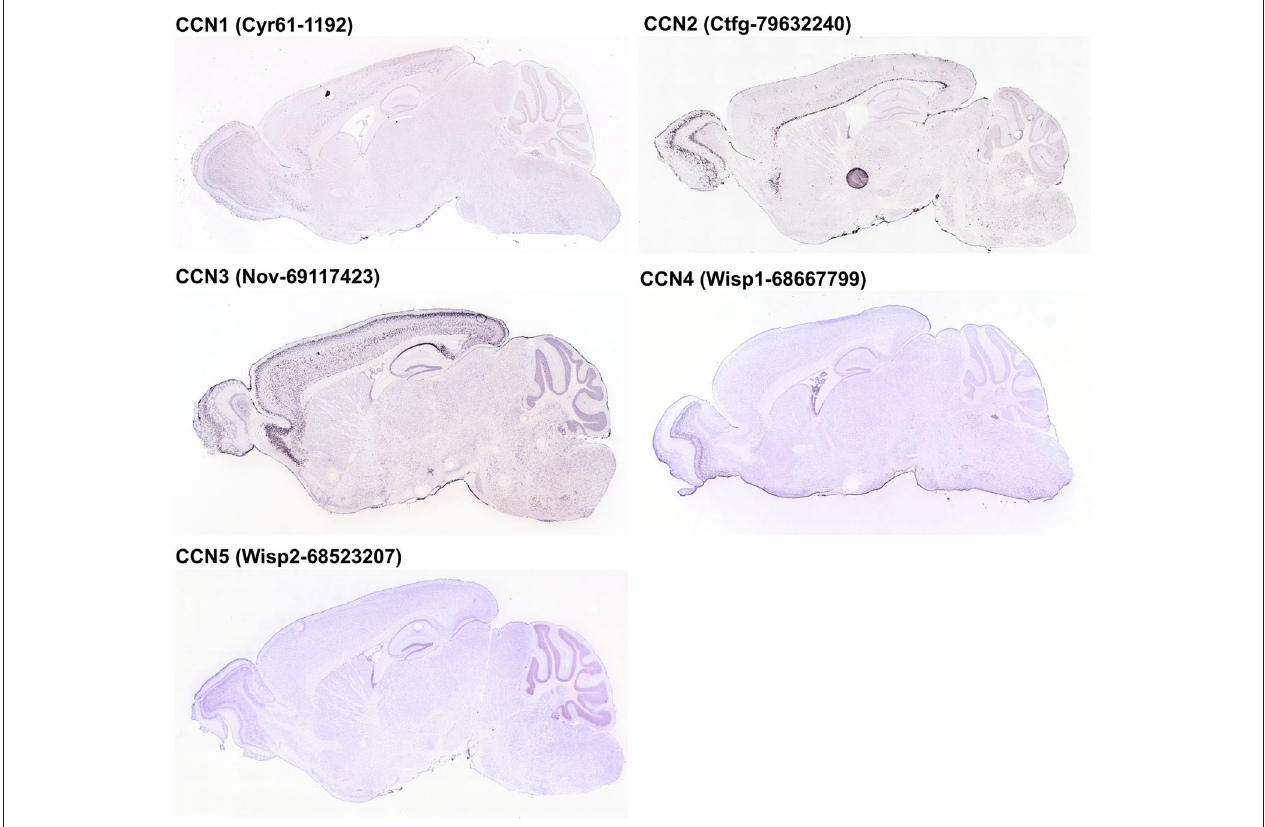
FIGURE 4 | CCN protein abundance in the selected human brain regions according to the Human Protein Atlas (HPA) .